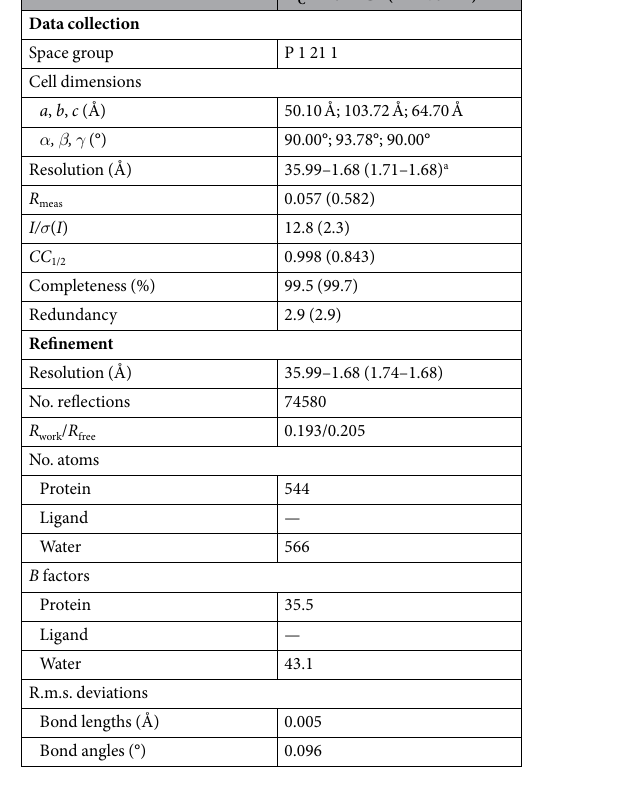
Table 1. Data collection and refinement statistics. a Values in parentheses are for the highest-resolution